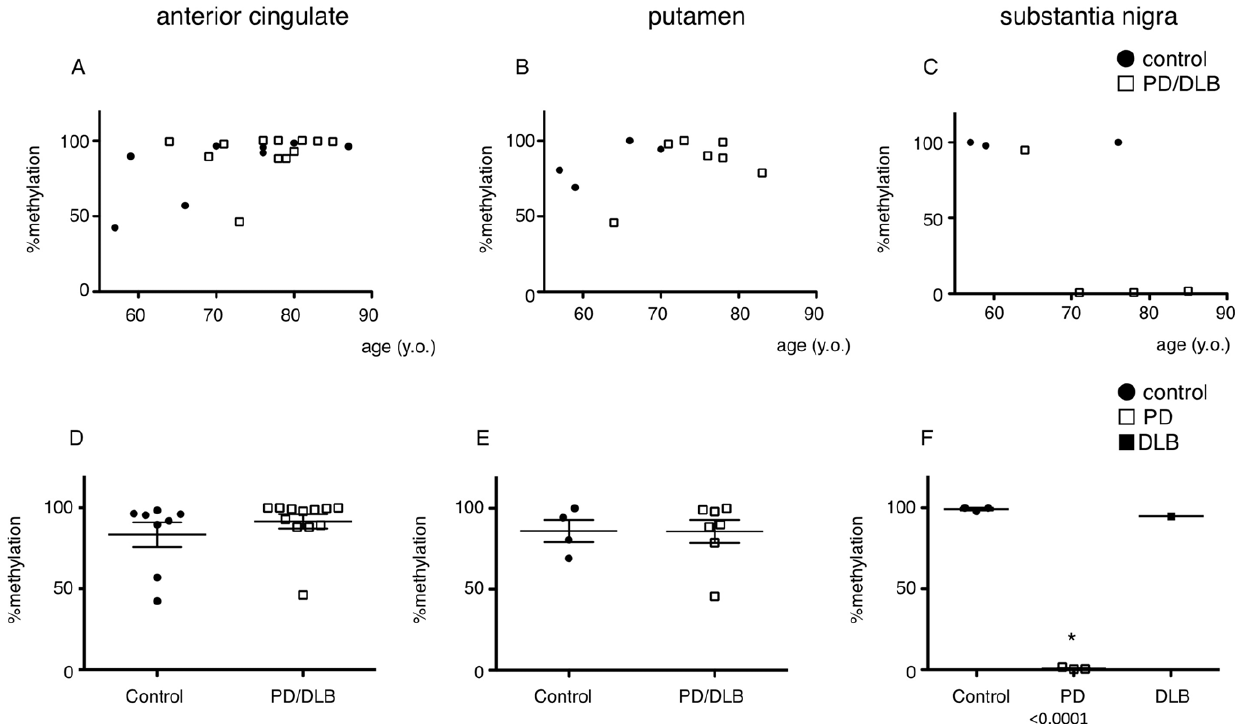
Figure 4. Analysis of CpG-2 methylation level in various brain regions. A–C : CpG-2 methylation was analyzed by bisulfite sequencing and plotted against age. Data from anterior cingulate cortex (control: n=8, PD/DLB: n=12) (A), putamen (control: n=4, PD/DLB: n=7) (B), and substantia nigra (control; n=3, PD/DLB: n=4) (C) are shown. Closed circle=controls, open box=PD/DLB. In figure 4C, age and % methylation had no significant correlation P=0.2321. D–F: CpG-2 methylation was analyzed by bisulfite sequencing method and plotted by disease groups. Data from anterior cingulate cortex (D), putamen (E) and substantia nigra (F) are shown. Closed circle=controls, open box=PD, closed box=DLB P , 0.0001 vs. control. doi:10.1371/journal.pone.0015522.g004 PLoS ONE |